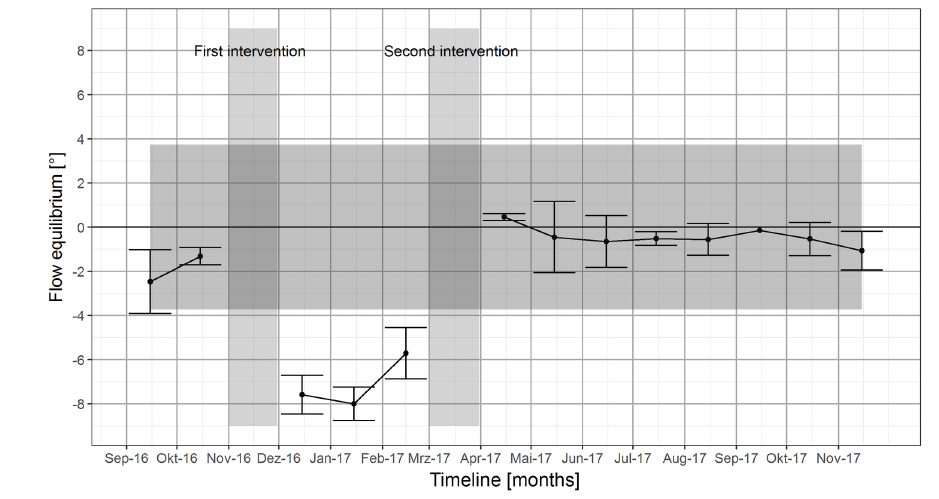
Figure 16. Monitoring the flow equilibrium with a moving window at Turbine WT2. Both changes in the alignment of the turbine are marked with vertical grey ribbons and the change in the resulting angle is clearly visible. The error bars are 1 standard deviation and the black dots are the median of all intersections per evaluation period (here: 1 month). The grey horizontal ribbon is a 90% confidence